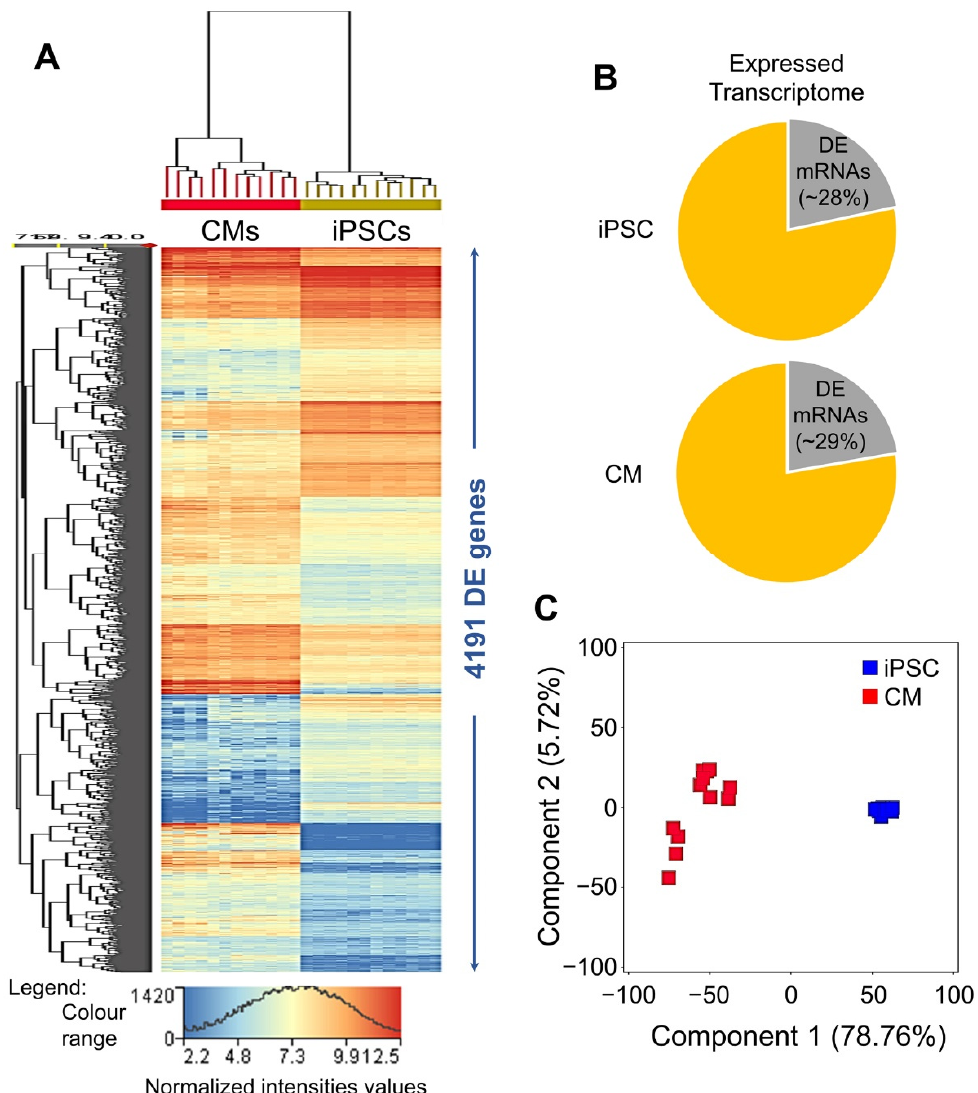
Figure 3. Genome-wide differential gene expression analysis of 12 iPSCs and their differentiated 12 CM lines. ( A ) Heat map of differentially expressed (DE) genes between 12 iPSCs and their 12 differentiated CM lines. ( B ) Pie graph showing average DE vs. total expressed transcriptome in 12 iPSCs and their differentiated CM lines. ( C ) Principal component analysis (PCA) of genes found DE between 12 iPSCs and their 12 differentiated CM lines.